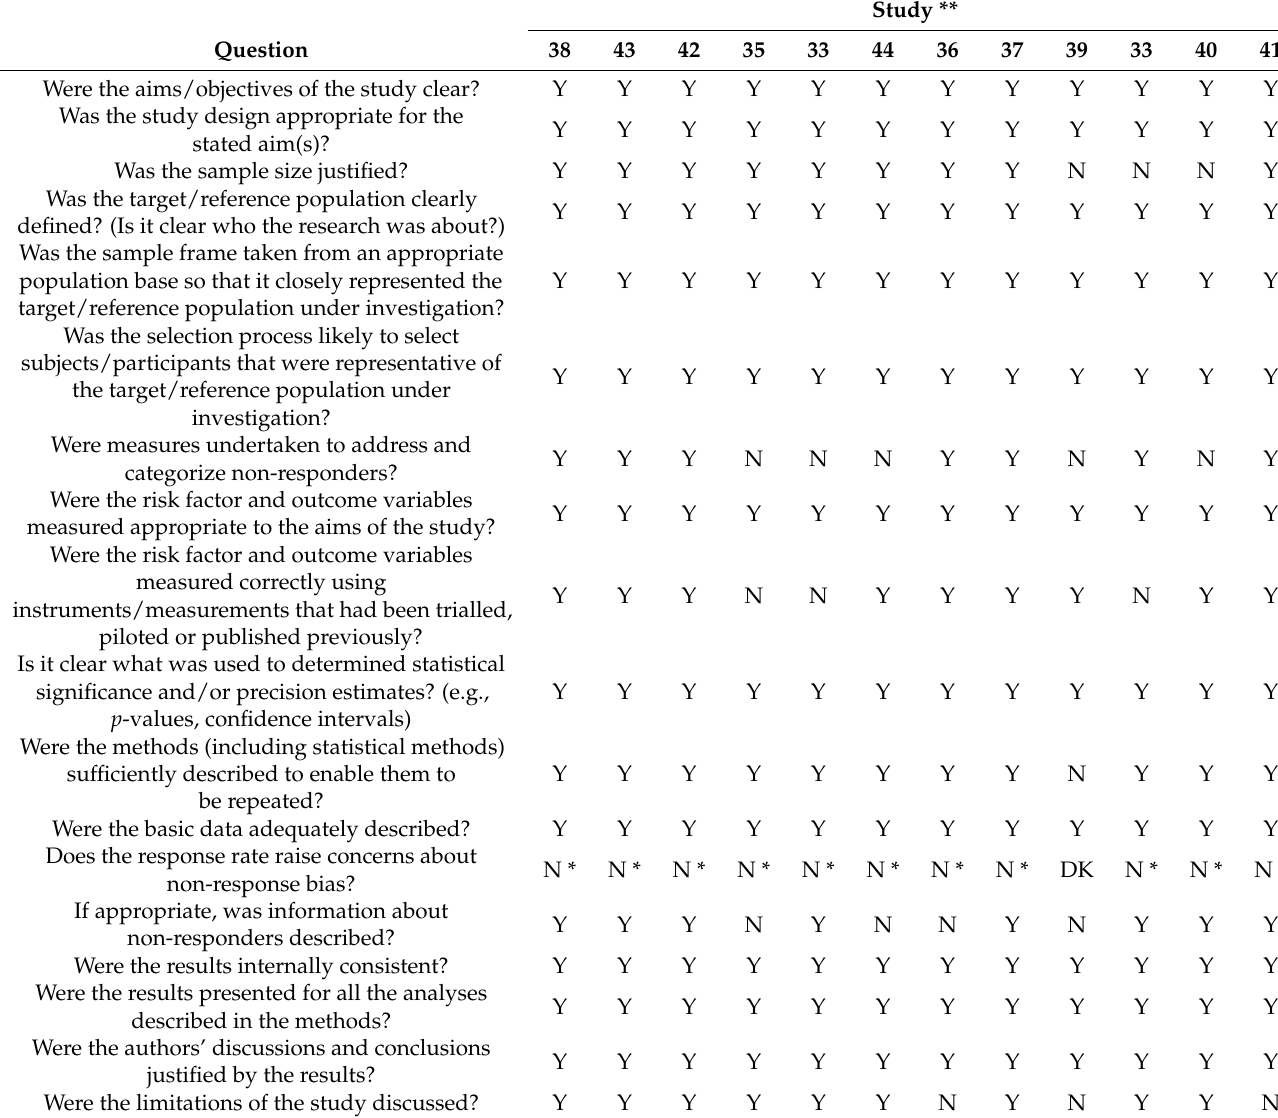
Table 3. Quality assessment of studies using the AXIS